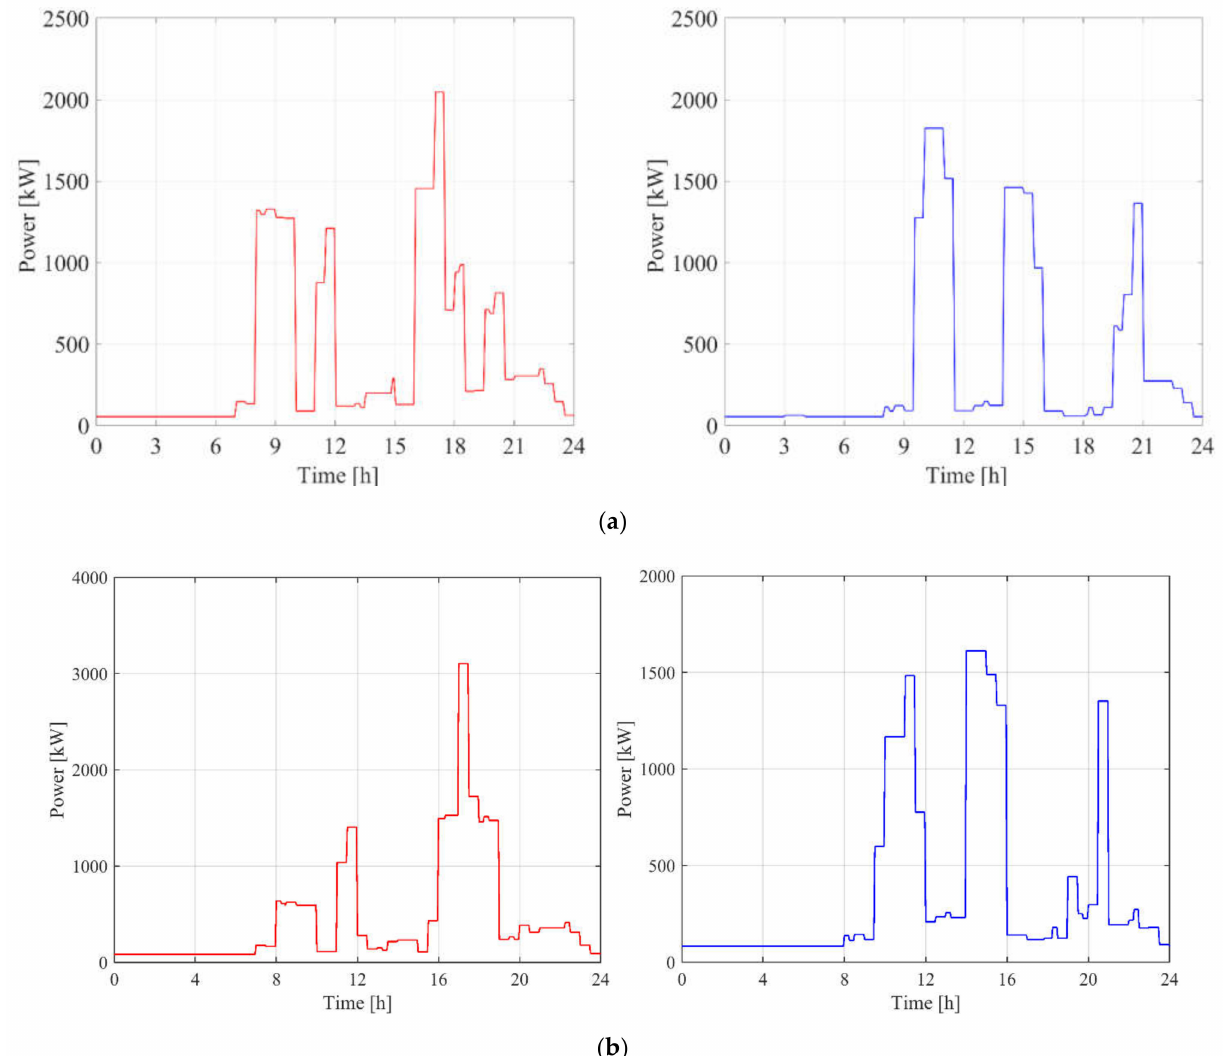
Figure 6. Thermal energy demand profile for a representative winter day (left) and a representative summer day (right) of the districts located in ( a ) Naples and ( b )